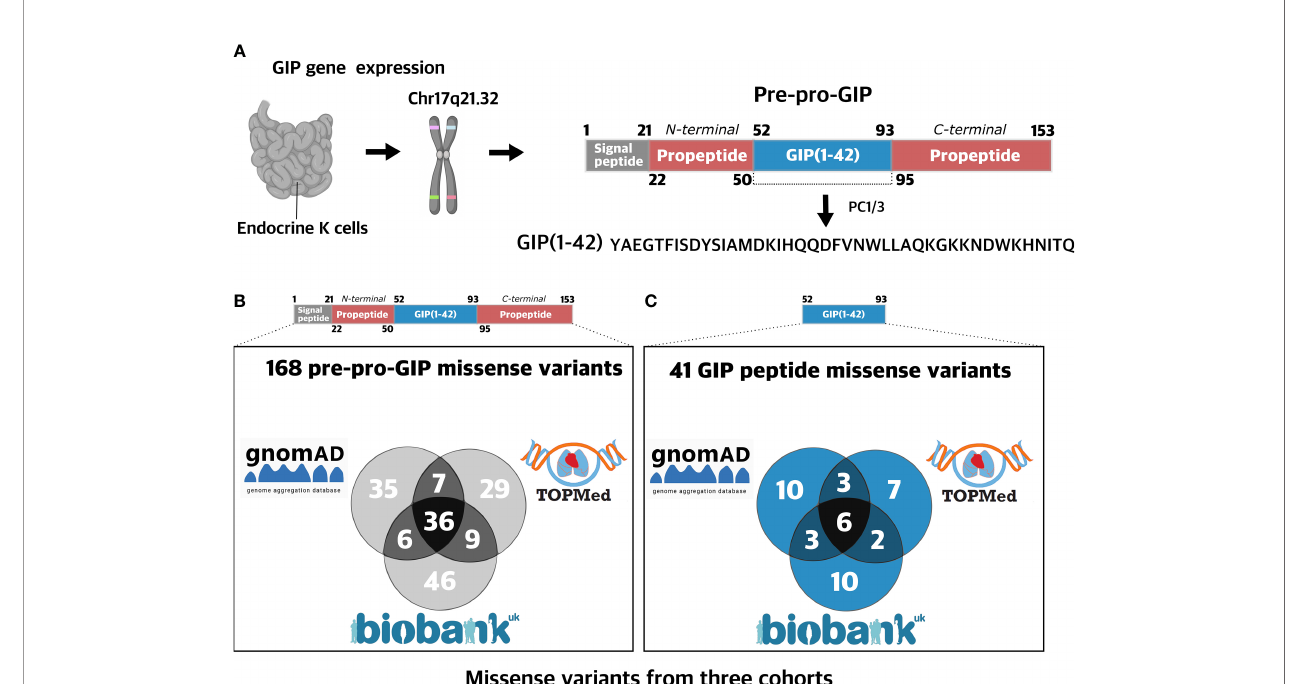
FIGURE 1 | Prevalence of missense variants in the GIP gene. (A) The human glucose-dependent insulinotropic polypeptide (GIP) gene is located on chromosome 17q21.32 and is mainly expressed in the stomach and in K cells of the small intestine epithelium (1). The GIP peptide is derived from a 153 amino acid prohormone, pre-pro-GIP, encoding four domains: a signal peptide (1-21), an N-terminal propeptide fragment (22-50), GIP(52-93), and a C-terminal propeptide fragment (95-153). Intracellularly, GIP(1- 42) is liberated from the prohormone upon processing via PC1/3 cleaving at single arginine residues (19). (B) 168 missense GIP gene variants were aggregated from three independent cohorts with a total of 721,991 participants: UK Biobank (454,787 exomes) (20), gnomAD (125,748 exomes and 15,708 genomes) (21), and TOPMed (132,345 exomes) (22). The variants are found in 105 different amino acid positions (69%). (C) 41 missense variants identi fi ed in the GIP gene were found in the sequence encoding the biologically active GIP(1-42) peptide spanning 24 different amino acid positions (57%). Figure 1A Created with